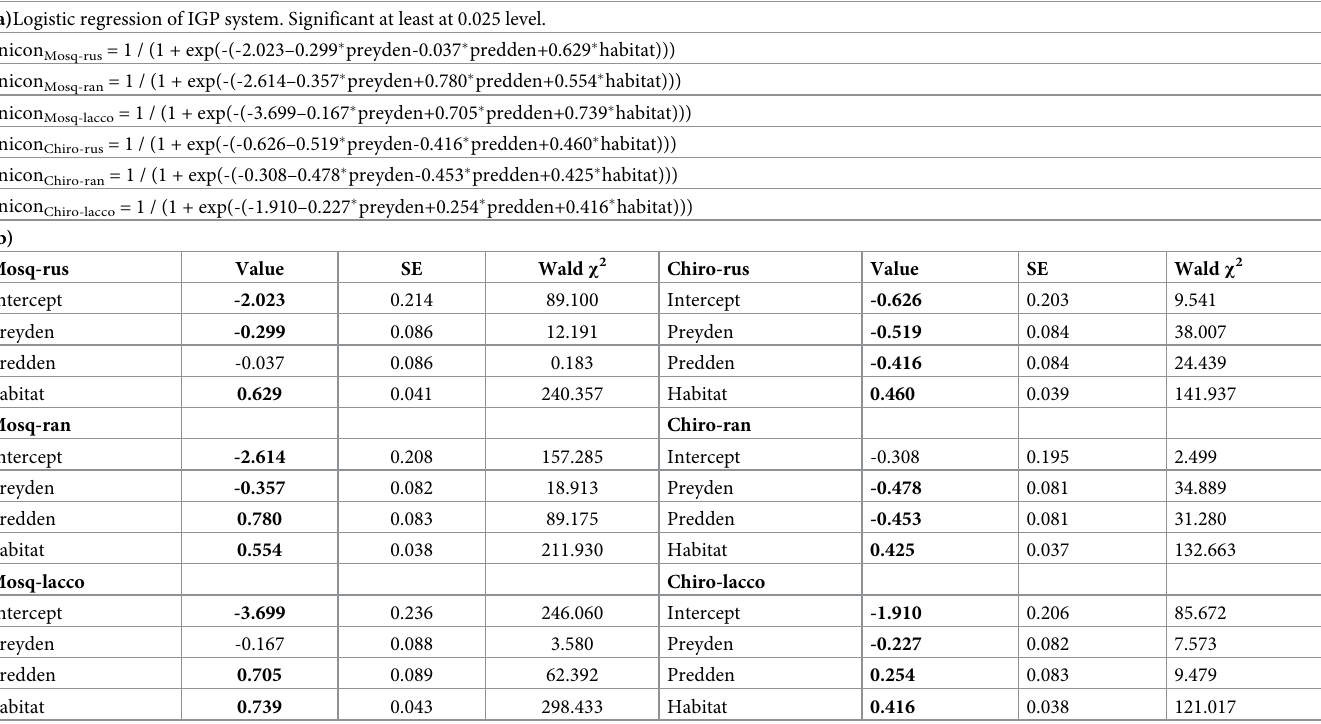
Table 2. The logistic regression on the IG prey consumed (anicon) against shared prey density (preyden), predator density (predden) and habitat complexity (habi- tat) as the explanatory variables. The level of significance is 0.025. (b) Significant values of the parameters of the model (in bold) were deduced through the Wald’s Chi- square test represented below. Here, the prey predator combinations were, mosq–Mosquito larvae, rus– D . rusticus , Chiro–chironomid larvae, ran- R . filiformis , lacco– L . griseus